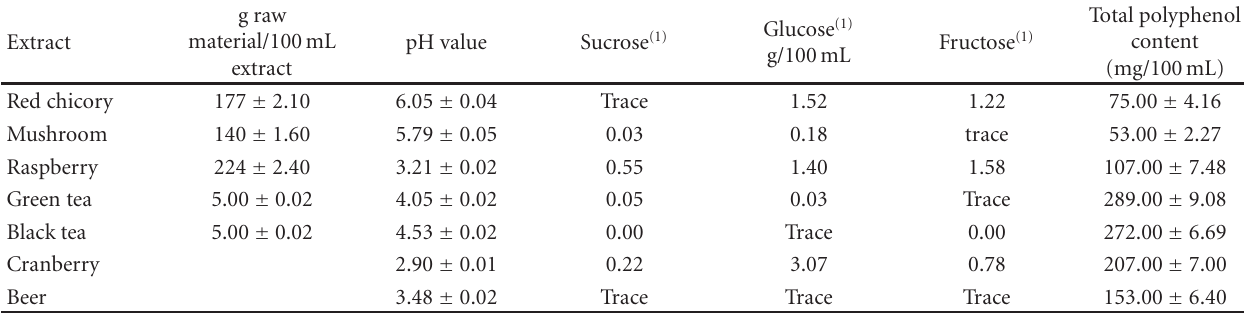
Table 6: Amount of raw food needed to obtain 100mL of extracts, the extract pH values, sugars, and total polyphenols content of the